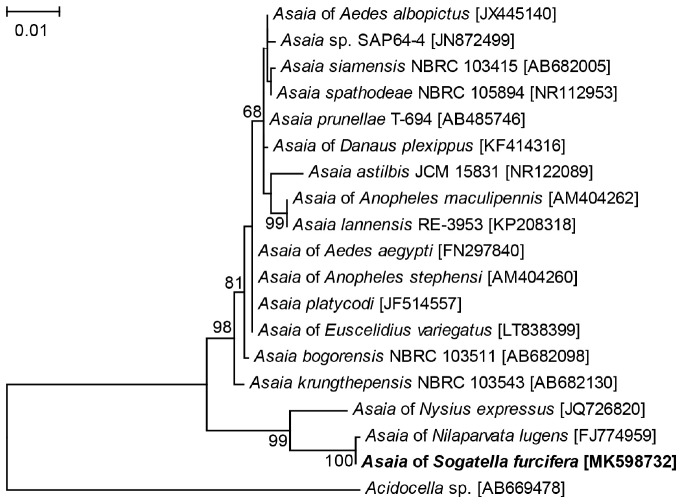
Phylogenetic tree based on Asaia 16S rRNA gene sequences. The tree was constructed using HKY + G model for ML method. The names and sequence GenBank accession numbers (in parentheses) are shown. Sequences obtained in this study are shown in bold. Only Bootstrap values >50 are represented. Acidocella sp. of the family Acetobacteriaceae is used as outgroup.